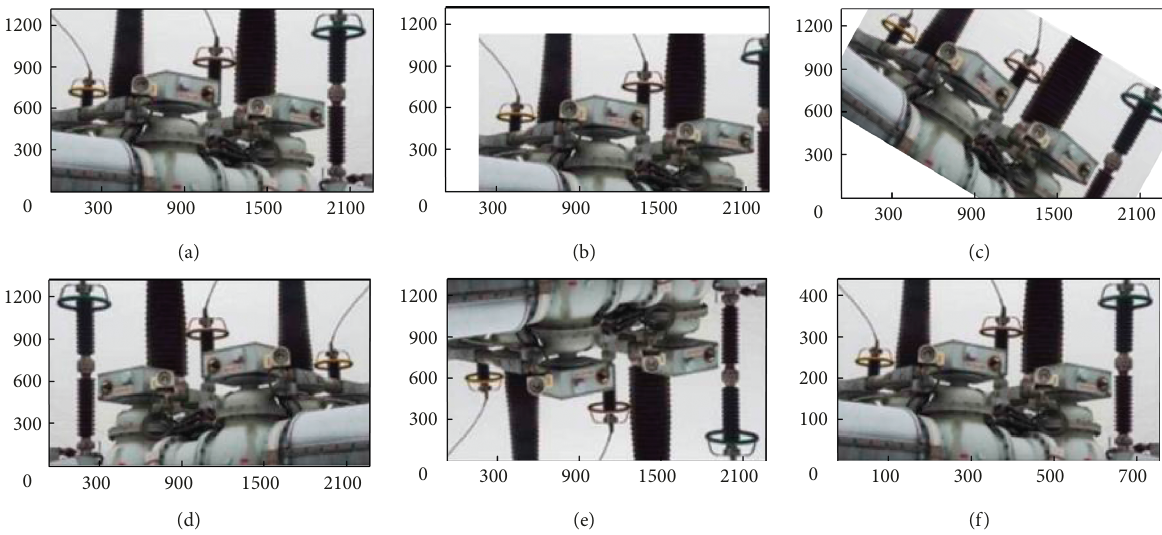
Figure 3: Comparison before and after image transformation. (a) The original image. (b) Translation transformation. (c) Image rotation. (d) Image horizontal flip. (e) Image flip vertically. (f) Image scaling.